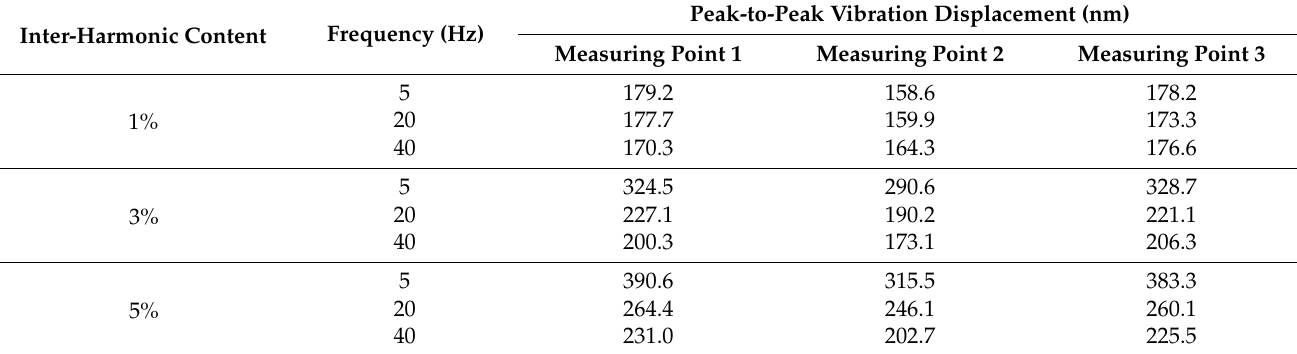
Table 5. Peak-to-peak vibration displacement with voltage amplitude of 44.12